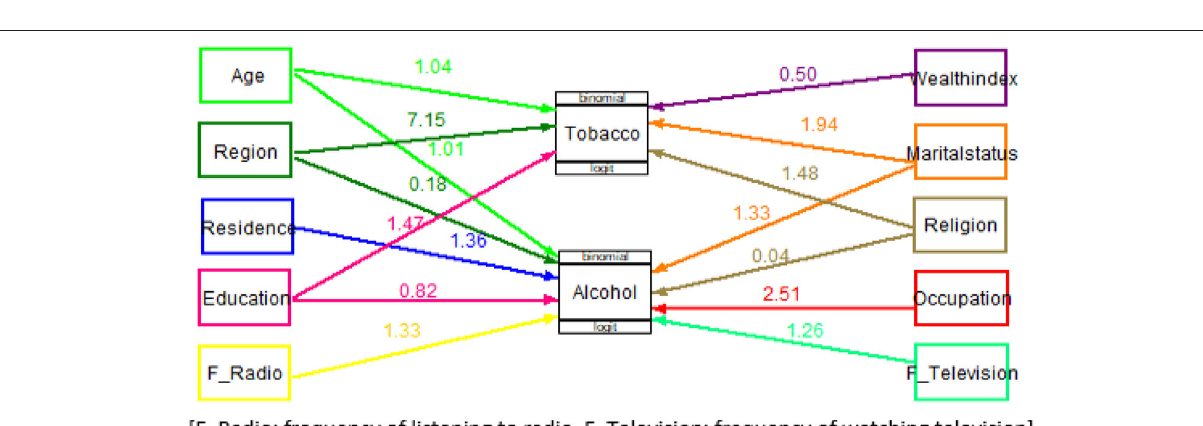
FIGURE 4 | Primary and secondary clusters of risky health behavior among adult males across regions in Ethiopia, 2016.